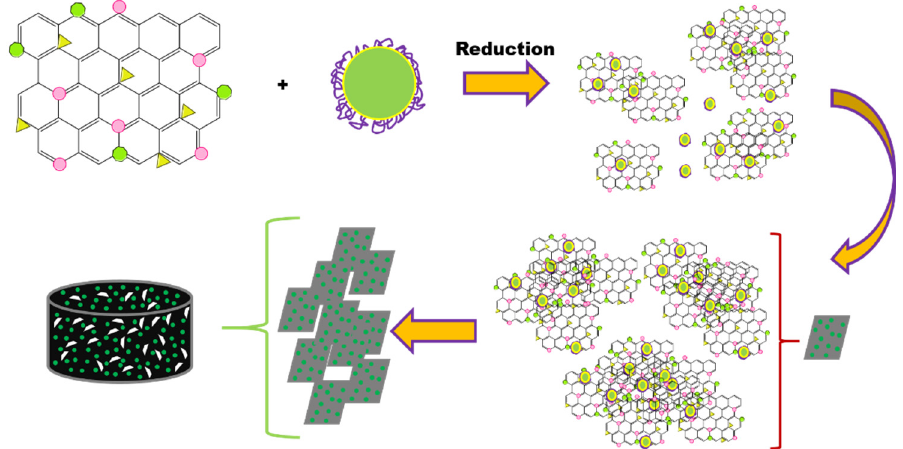
Figure 2. Preparation of the composite monolith of rGO/CeO 2 /polymer brushes.